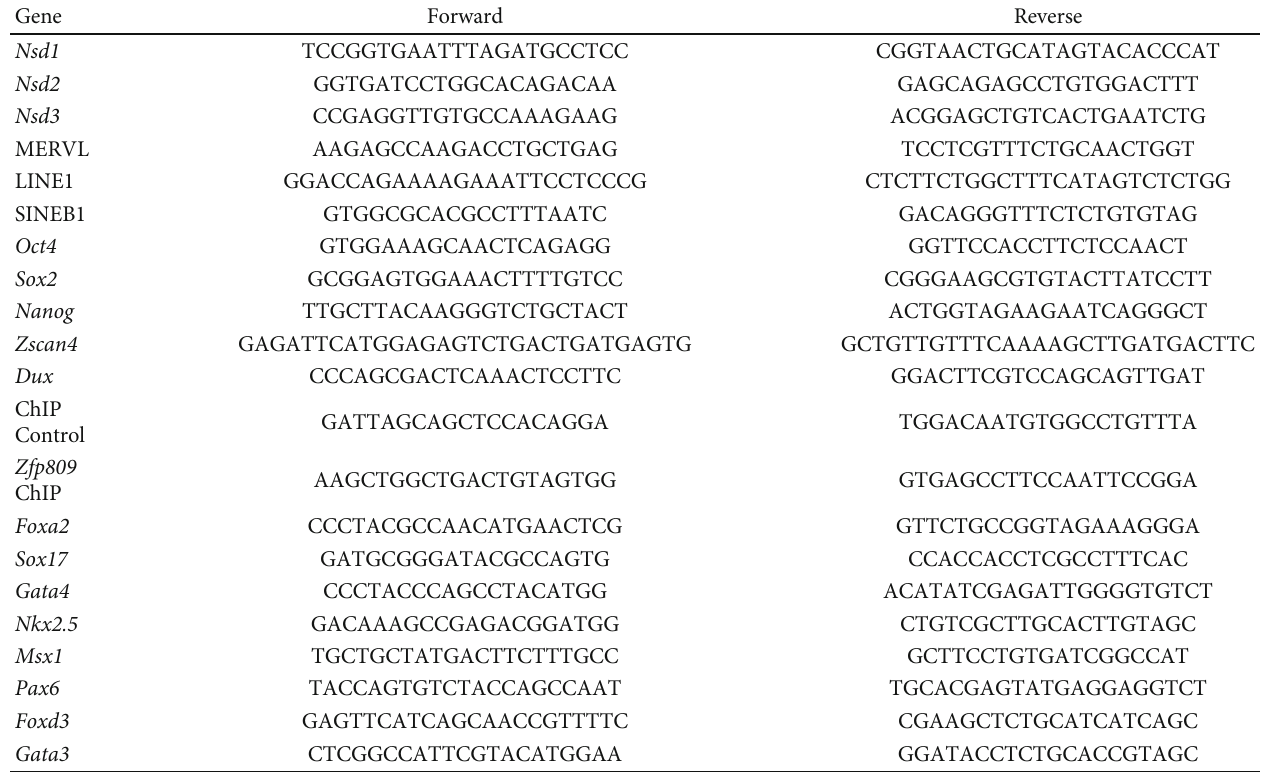
Table 1: Primers for qPCR